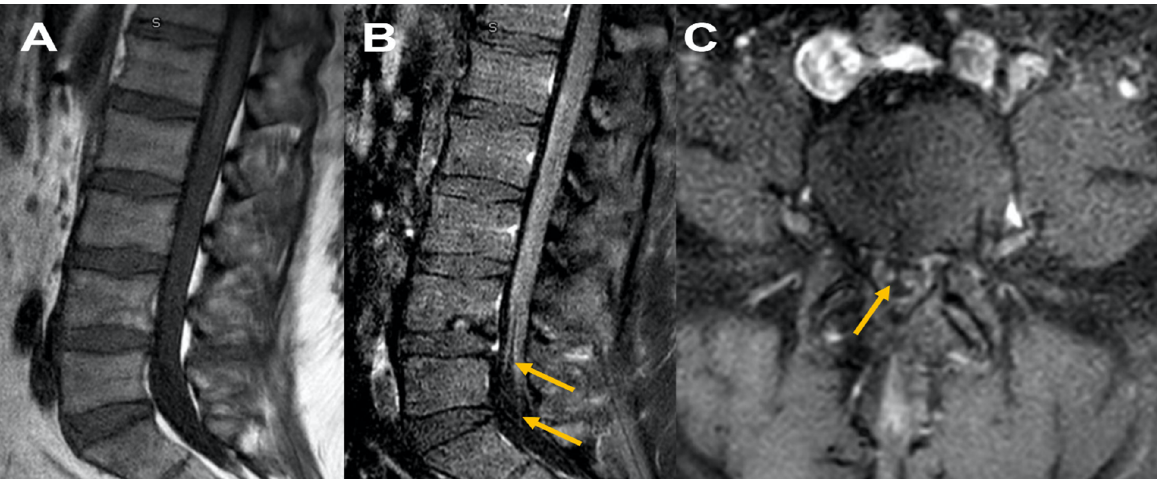
Figure 2. MRI Lumbar spine Figure 2, sagittal T1 plain 2 ( A ) and corresponding sagittal post contrast T1 2 ( B ) and axial cuts at L5 level 2 ( C ) reveal normal appearing disc and facets, 1( A ); cauda equina nerve roots are thickened with no abnormal enhancement consistent with chronic inflammatory demyelinating polyneuropathy 2 ( B ) and 2 ( C ).